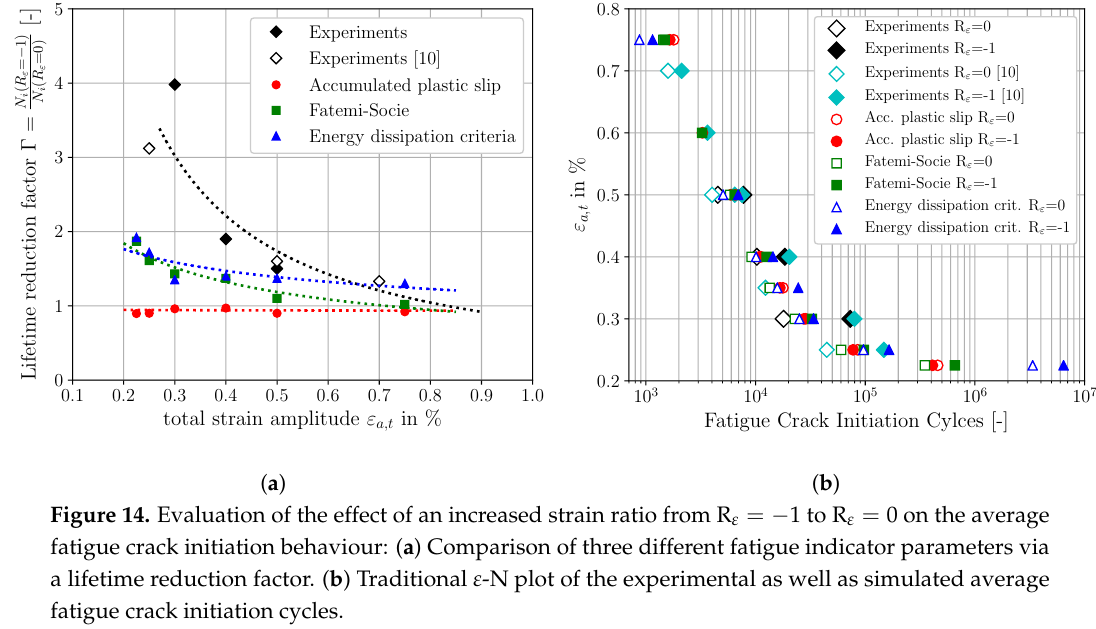
1 to R ε = 0 on the average −